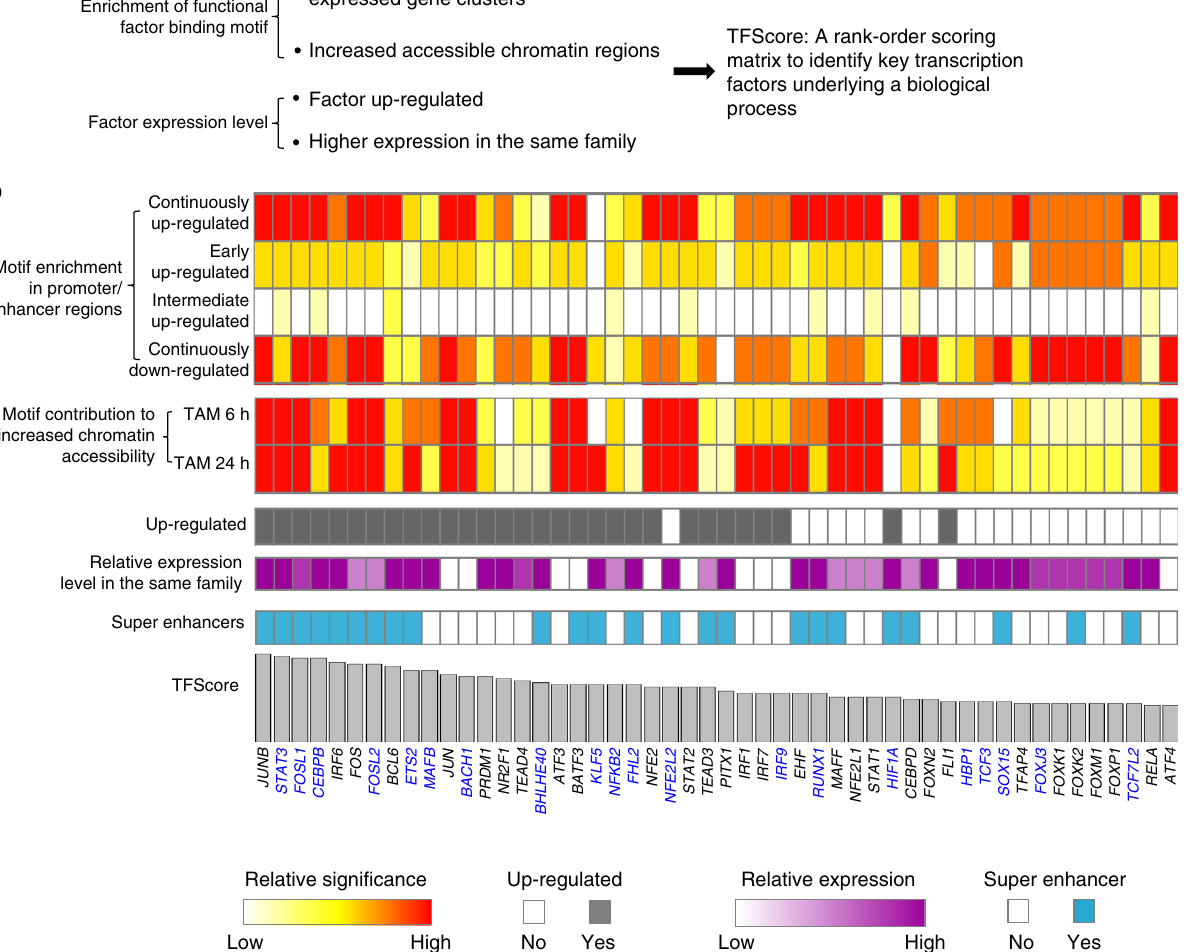
Fig. 4 Identifying transcription factors important for transformation. a Criteria for TFScore. See Methods for a detailed description. b Rank order of transcription factors potentially playing important regulatory roles during cell transformation, based on TFScores (top 50 are shown). For each transcription factor, the relative contribution of 4 criteria to TFScore, and annotated super-enhancer genes are shown. The 20 genes used for validation by siRNA knockdowns (Fig. 5) are shown in